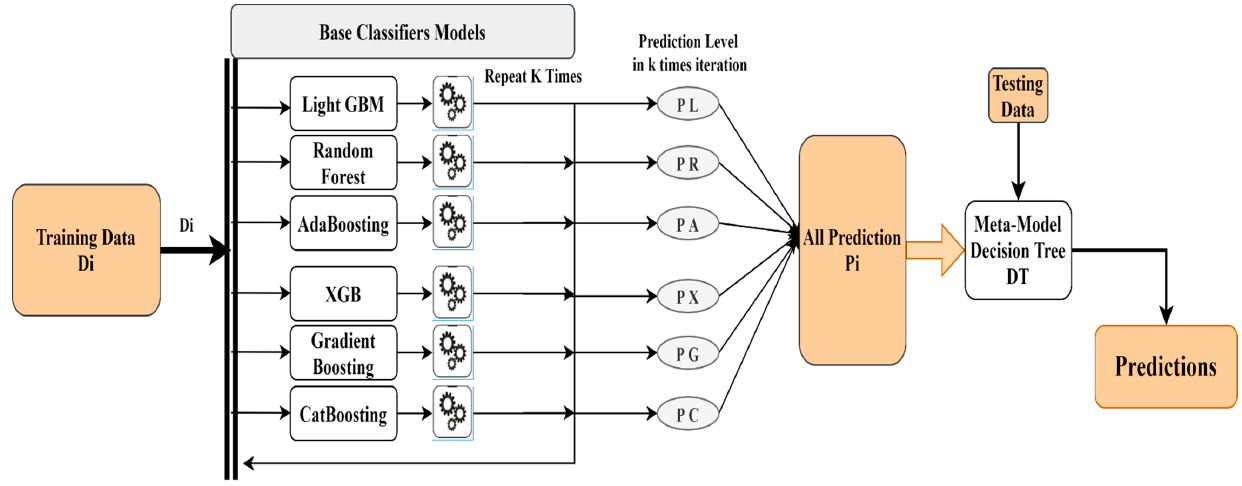
Figure 3. T he Meta-model structure. Figure 3. The Meta-model